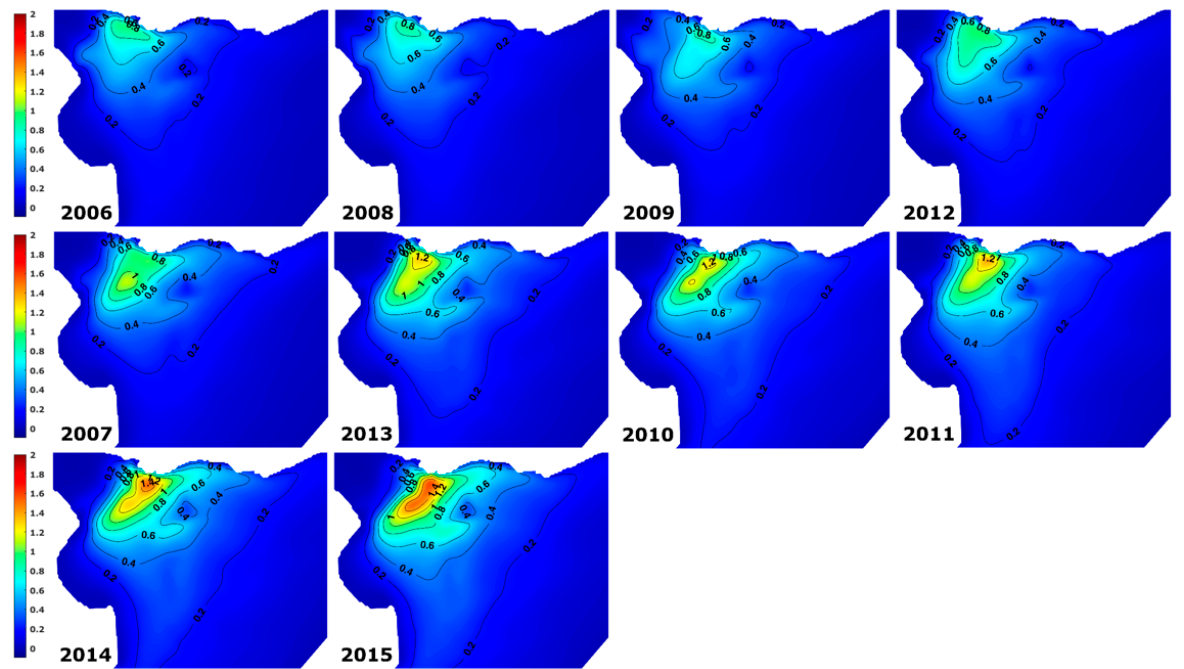
Figure 4. Annual normalised salinity stratification for the period 2006–2015, ordered according to increasing annual mean river flow. All maps are in geographic coordinates between Lat ( − 36.9, − 34.7) and Long ( − 57.4, 54.2).